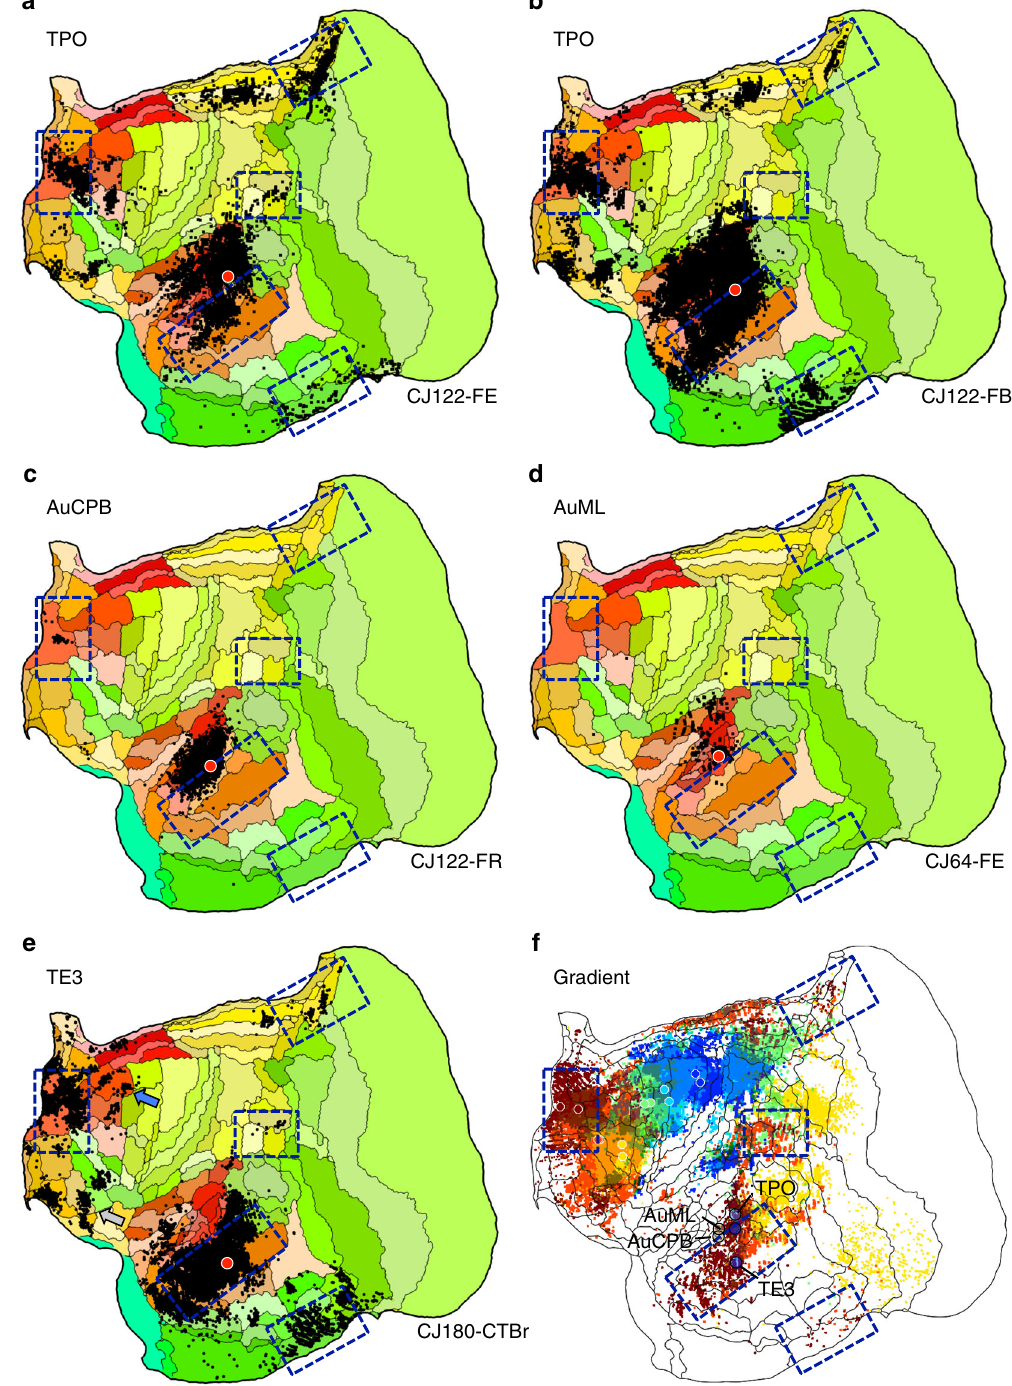
Fig. 4 Evidence for involvement of temporal association cortex in the apex transmodal network. Injections in estimated TPO ( a , b ) are distinct from injections to nearby auditory areas AuCPB and AuML ( c , d ). TPO injections receive projections from the full constellation of regions predicted as components of the default network-A candidate as well as nearby auditory areas, whereas the auditory areas receive projections predominantly from adjacent auditory areas. e Injection of TE3 also yields a default-network-like pattern, while largely sparing auditory cortex. f The gradient of temporal lobe projections to frontal regions is illustrated by combining the anterior projection patterns of Fig. 2 into a single multicolored image: A4ab, purple; A6DC, blue; A6DR, green; A8aV, yellow; A47L, orange; A10, red. A clear progression into rostral temporal association cortex is observed. The three blue circles mark the locations of the TPO and TE3 injections and the two tan circles mark the auditory cortex injections (AuCPB and AuML). In addition to revealing the network gradient, this composite image illustrates a region of temporal cortex where transmodal association areas that are part of the default-network- like candidate are near to auditory sensory areas (see also Supplementary Fig.